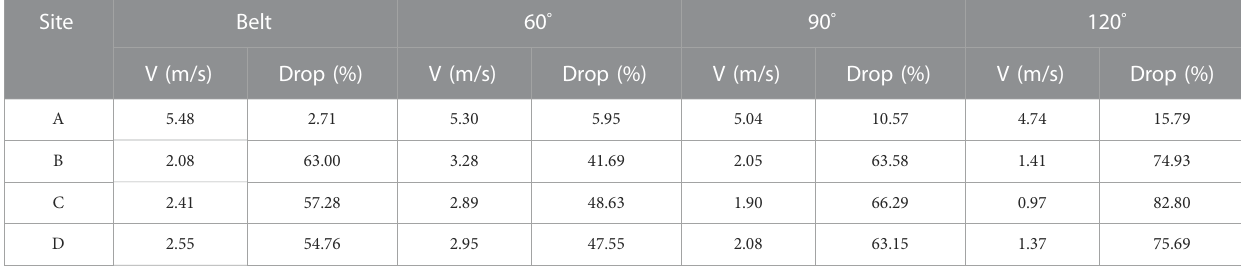
TABLE 2 Gradient table of wind speed at 0.1 m height near